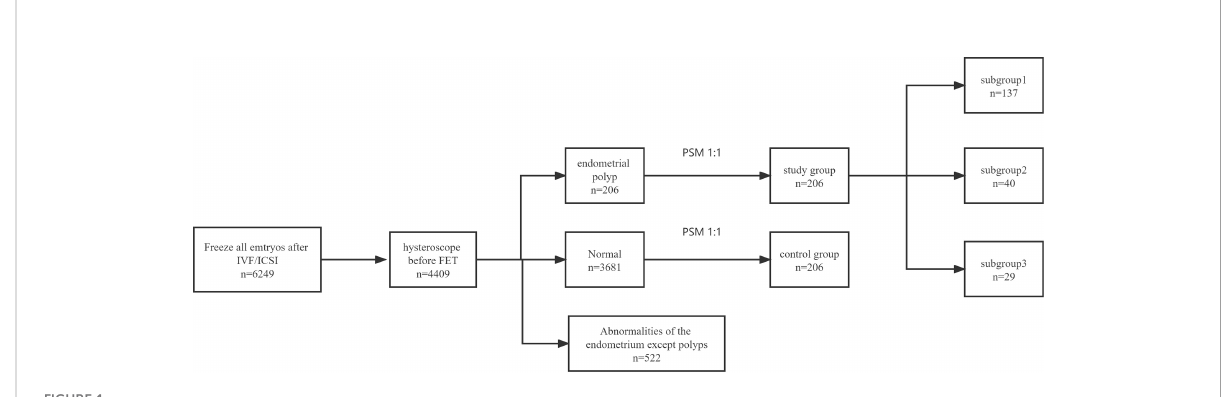
FIGURE 1 Flowchart of the included